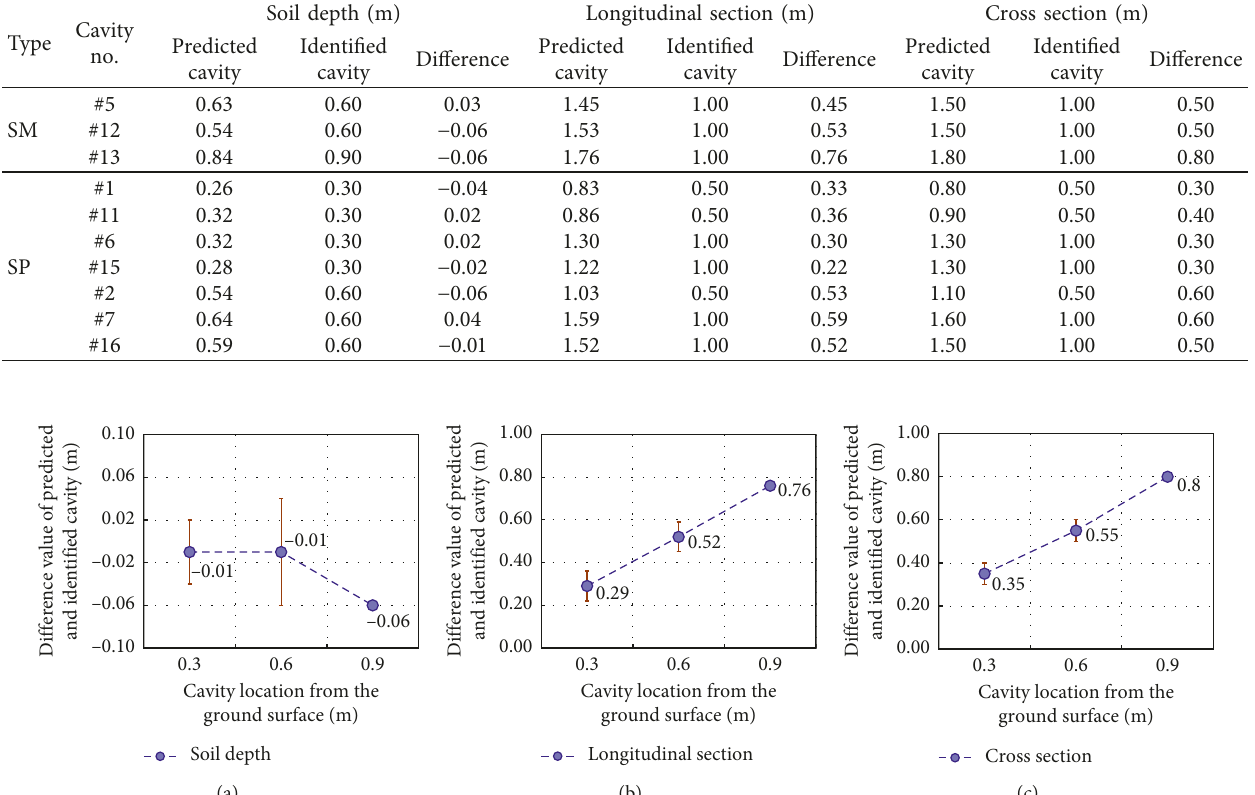
Table 5: Calculation results of the difference in soil depths and scales between the predicted cavity and the identified cavity. Cavity Type no.